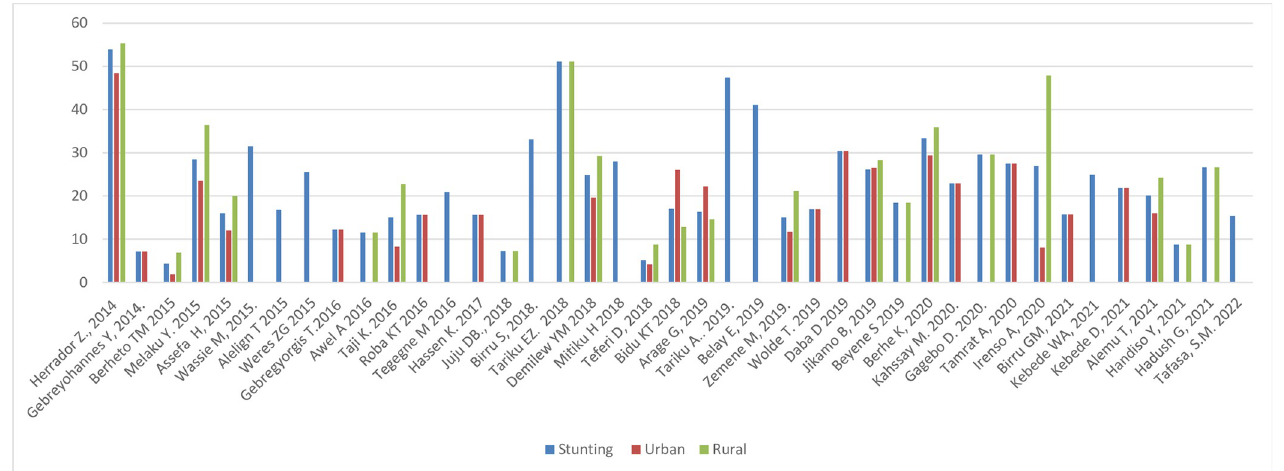
Fig 9. Trends in adolescent stunting by setting in Ethiopia over the last seven years.